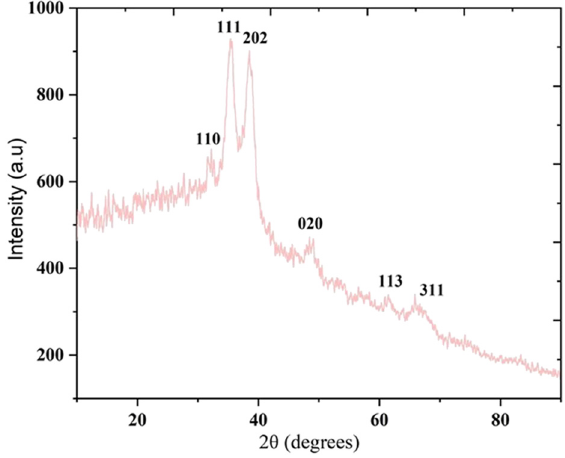
Figure 3: XRD pattern of biogenic CuO